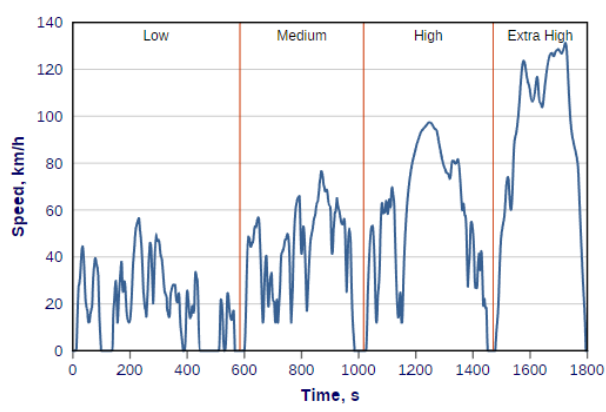
Fig. 2. The speed of the car during the WLTC category 3b cycle with the division into phases [1]